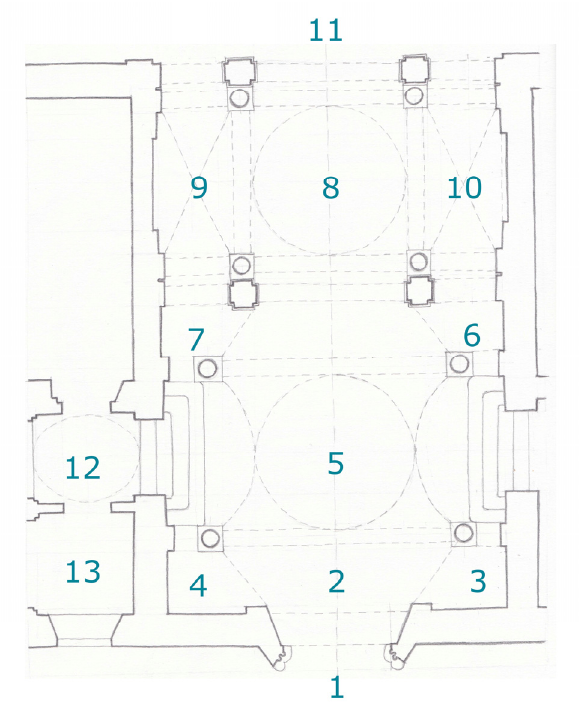
Figure 2 . Eidotype of the plan of Palazzo Mazzonis atrium, with the scan positions. Drawing: M. C. López González.